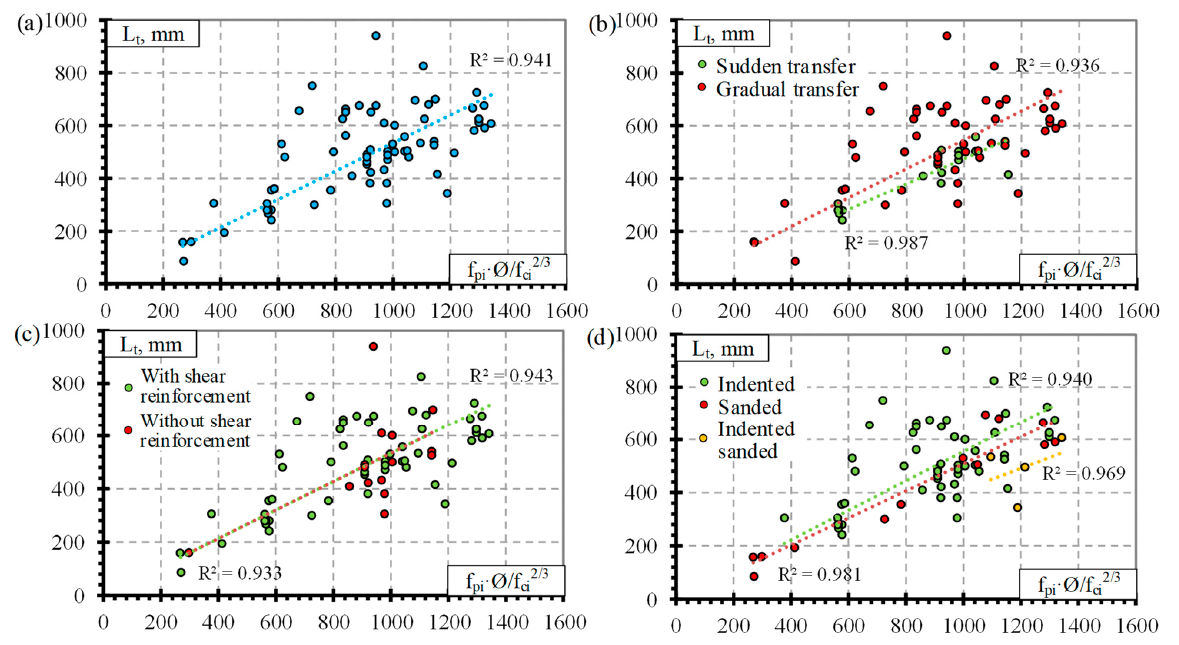
f / f ⋅∅ : ( a ) all results, ( b ) effect pi ci